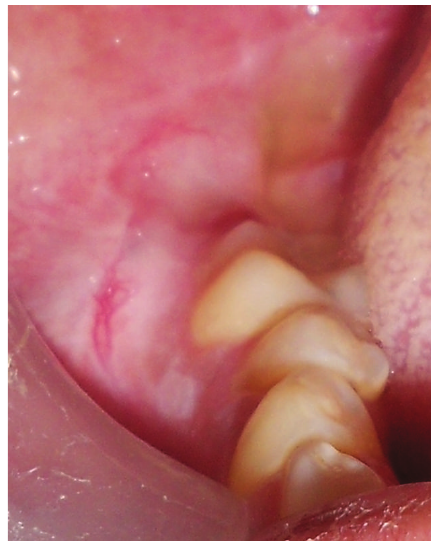
Figure 2: Intraoral view of the patient showing obliteration of the right lower buccal vestibule.